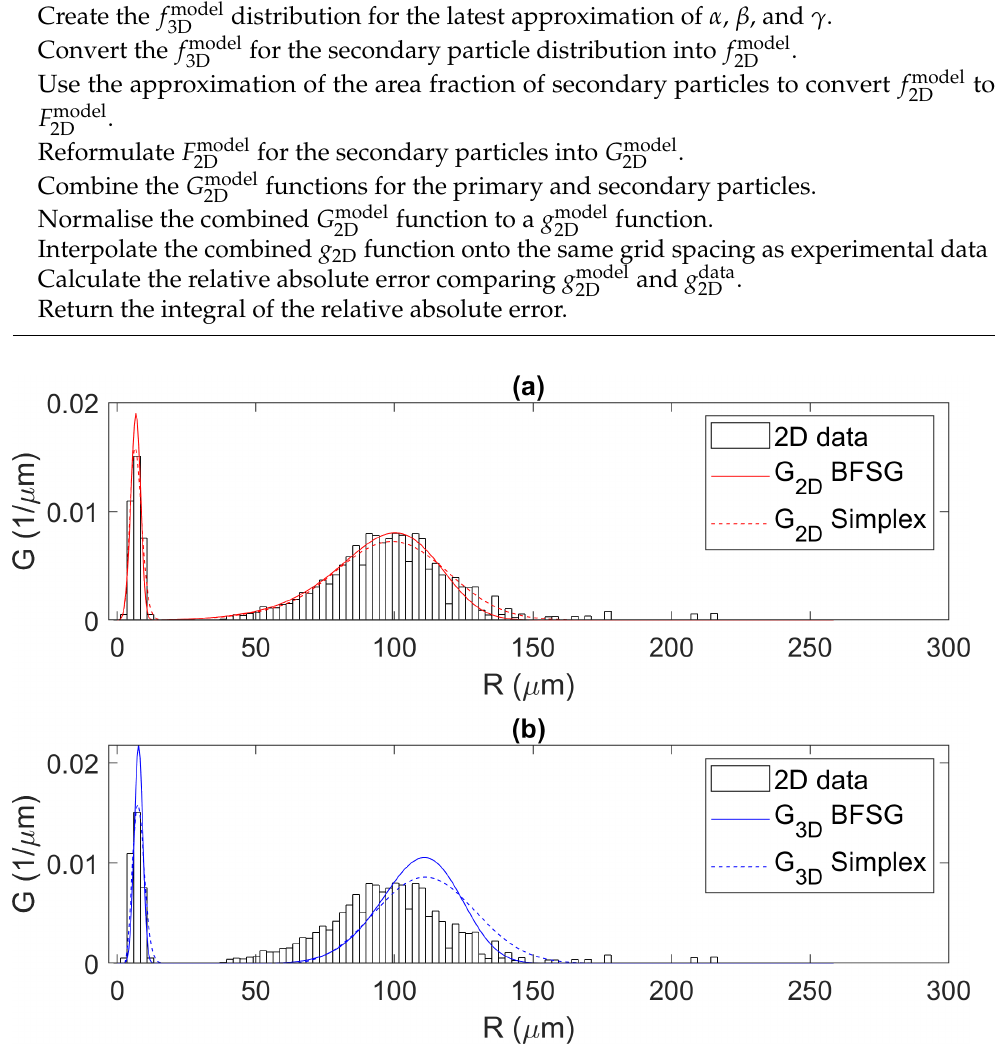
Figure 8. The results from the inverse analysis of the bimodal γ (cid:48) size distribution in as-heat-treated coarse grain RR1000, comparing the simplex and BFSG methods. ( a ) presents the measured 2D distribution of particle cross-sections compared with calibrated 2D approximations of the data obtained from a Python and MATLAB implementation. ( b ) presents the approximated 3D size distributions in comparison to the measured 2D